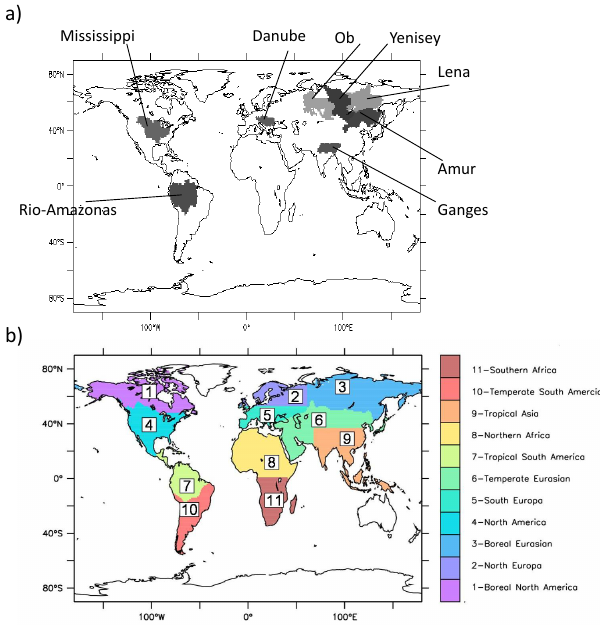
Fig. 2. (a) Map of the river basins considered in this study and (b) global breakdown into 11 regions inspired from the TRANSCOM atmospheric transport models intercomparison study (Gurney et al.,